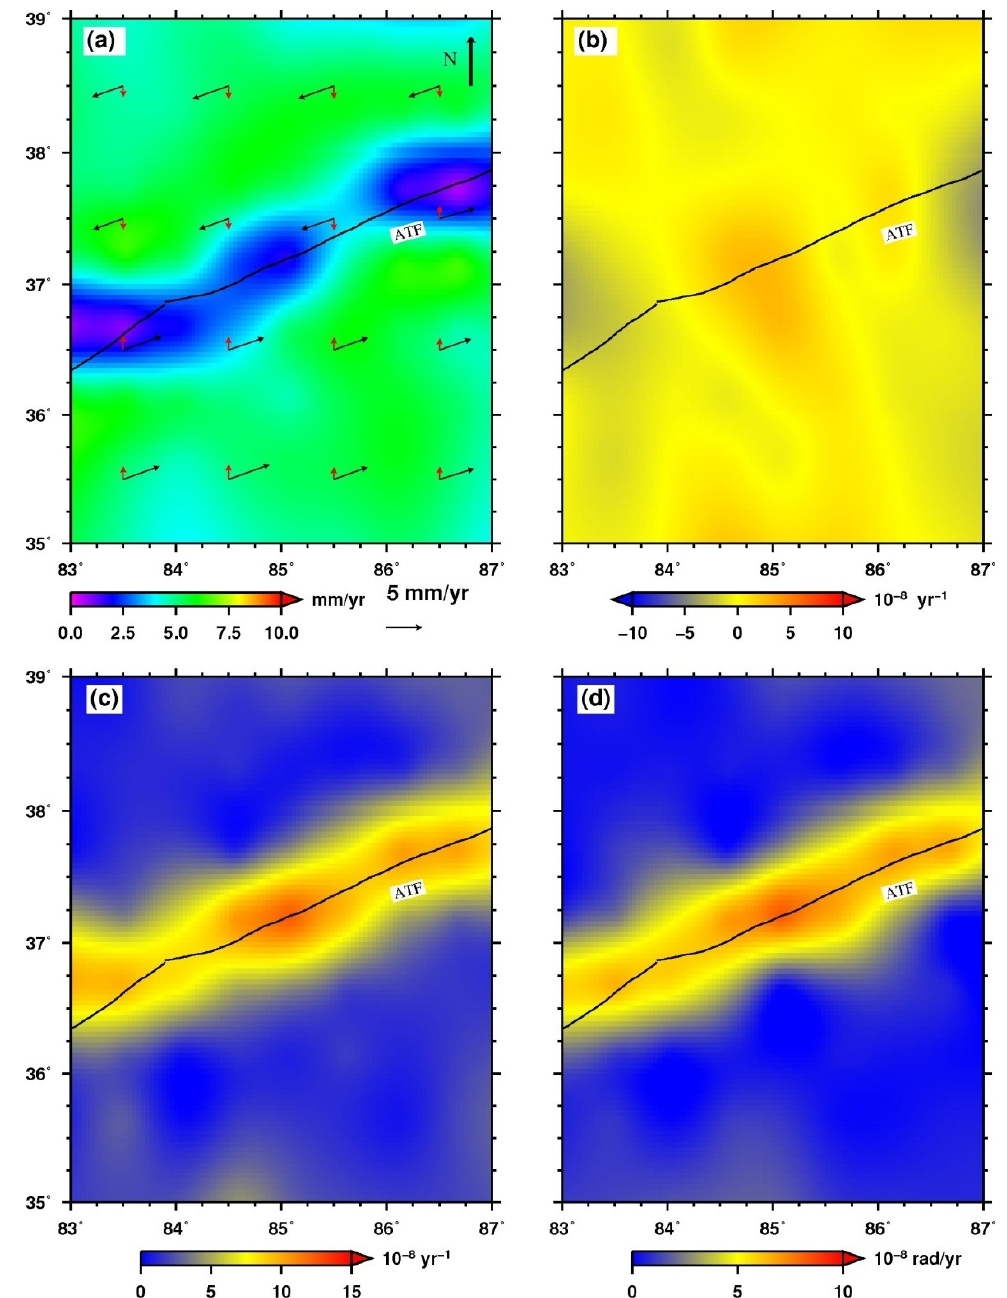
Figure 7. ATF strain map: ( a ) velocity map, the red arrows show the vertical velocity (directs north means upmotions and south means down motions) and the fat black arrow shows the north direction; ( b ) dilatation rate; ( c ) strain rate and ( d ) rotation rate.